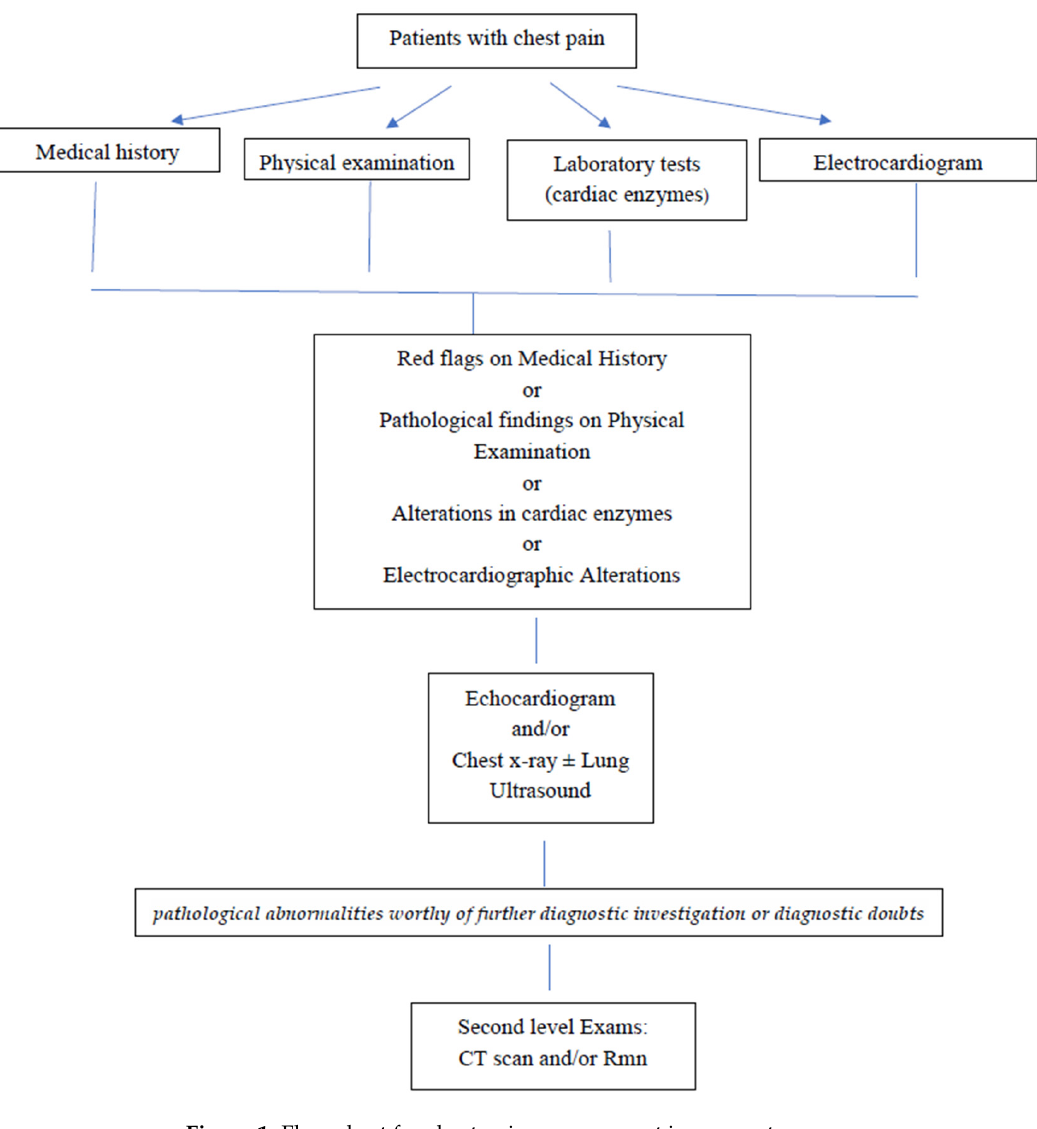
Figure 1. Flow chart for chest pain management in our center.